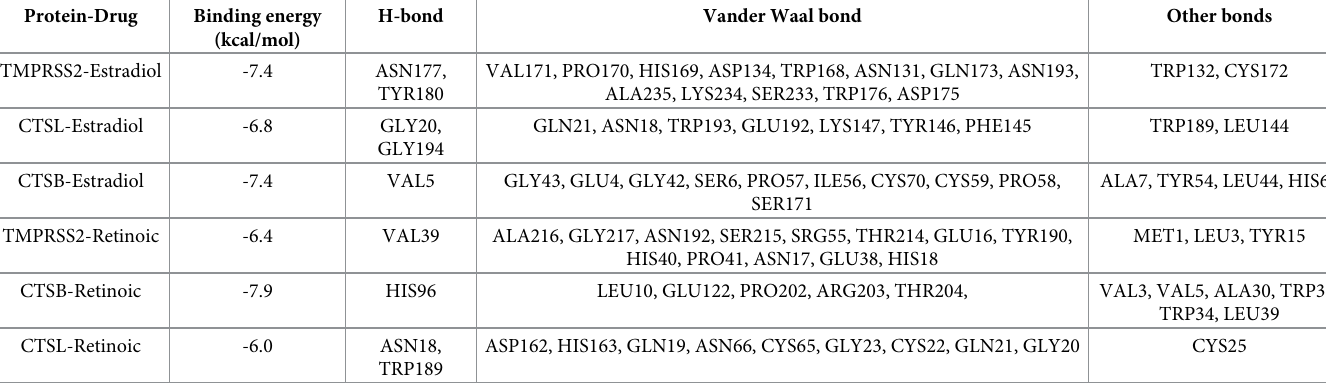
Table 1. Molecular docking results of estradiol and retinoic acid to target TMPRSS2 and CTSB/L. Protein-Drug Binding energy